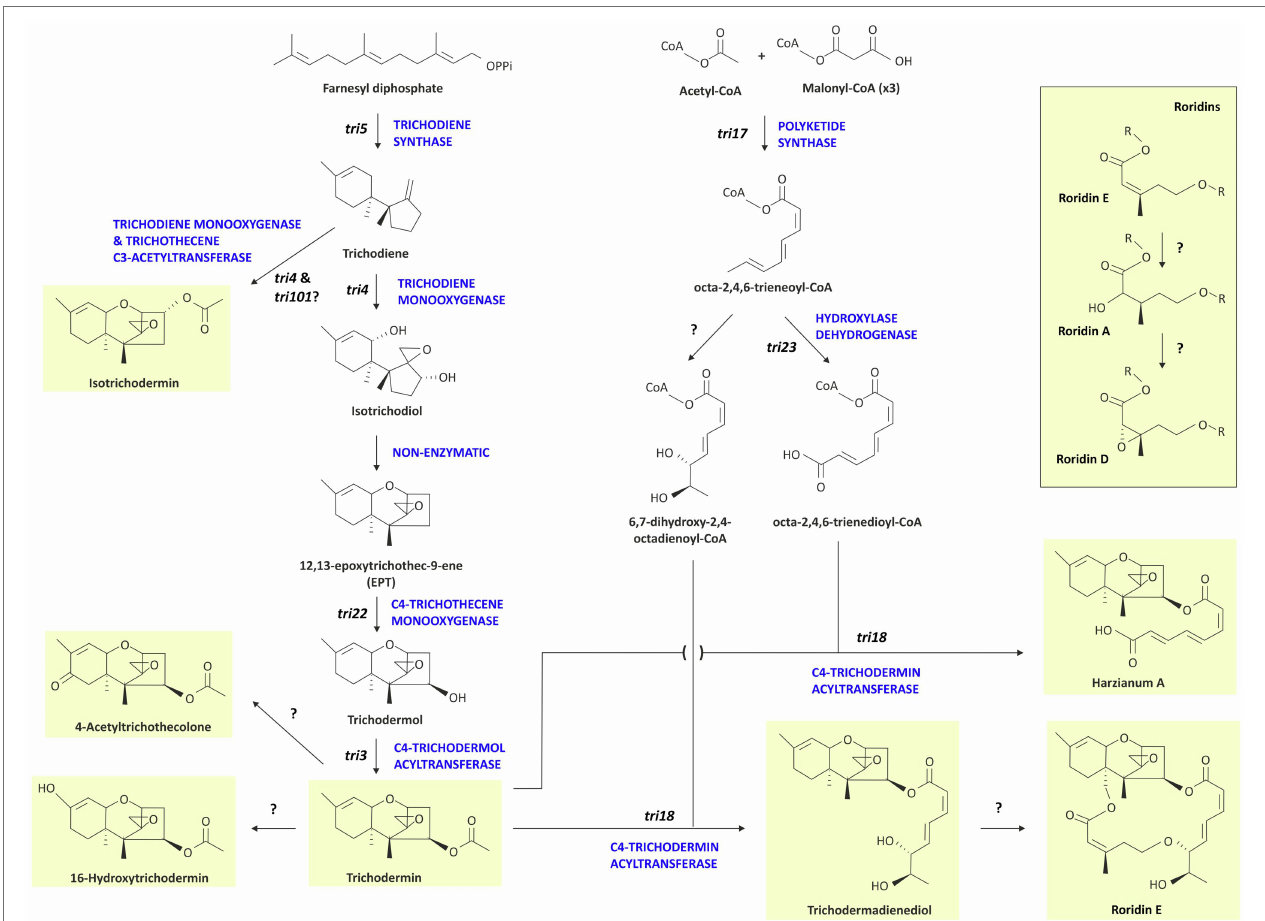
FIGURE 9 | Proposed biosynthetic pathway for Trichoderma trichothecenes. Arrows correspond to biosynthetic steps and enzyme activities already described, except for those labeled with question marks, which point out the genes not yet identified or characterized. Chemical structures shaded in yellow correspond to the final trichothecene analogs detected in the Trichoderma species analyzed in the present work and included in Table 1 . Genes are indicated in bold and black lowercase letters in italics, and enzymes are indicated by bold and blue uppercase